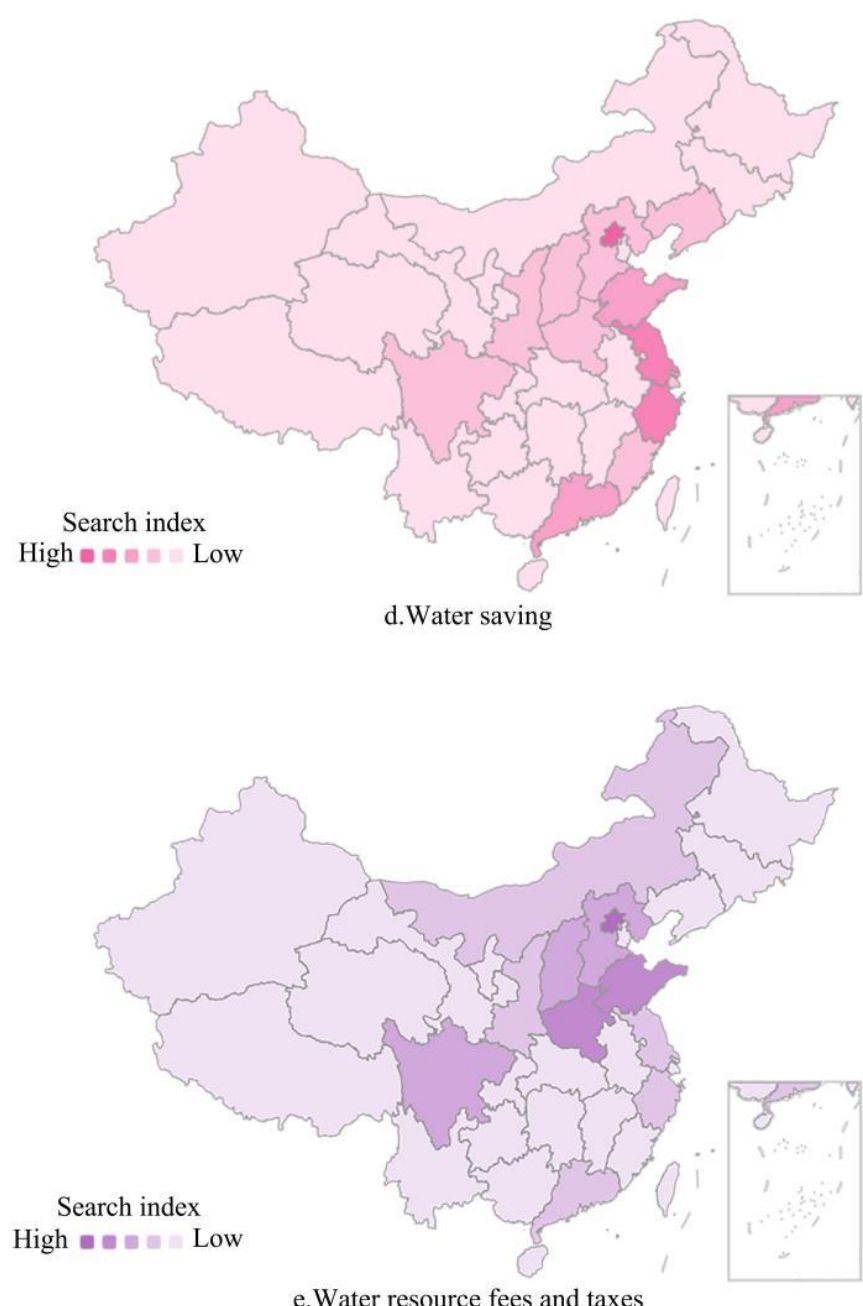
Figure 5. The geographical distribution of the Baidu search index for water-related keywords, 2011 –